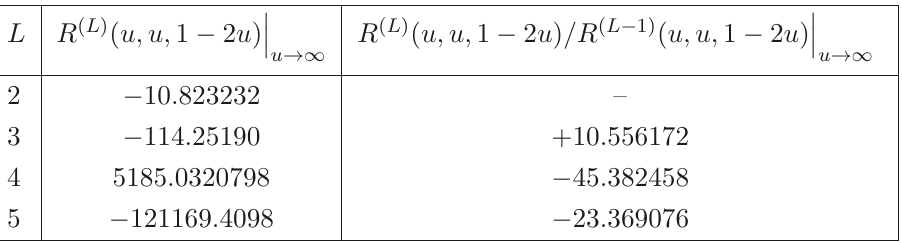
Table 9. The value of the L -loop remainder function at ( u, v, w ) = ( u, u, 1 − 2 u ) with u → ∞ , as well as the ratio to the previous loop